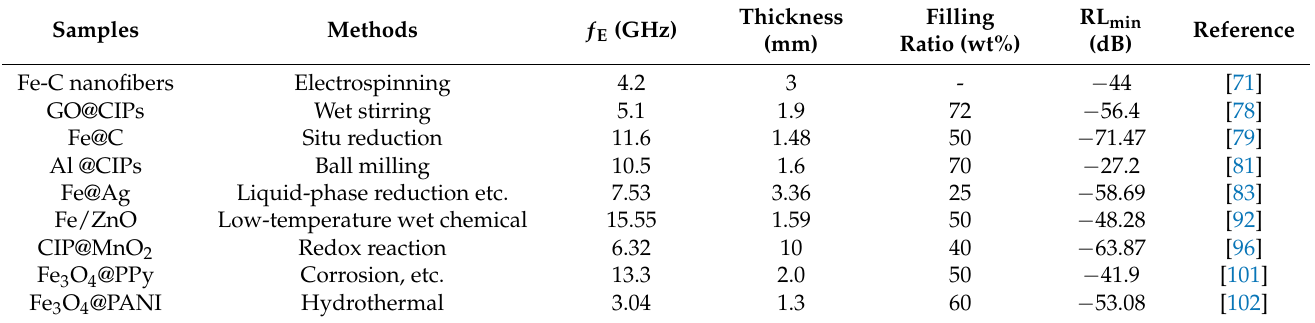
Table 5. The electromagnetic absorption performance of surface-coated Fe-based